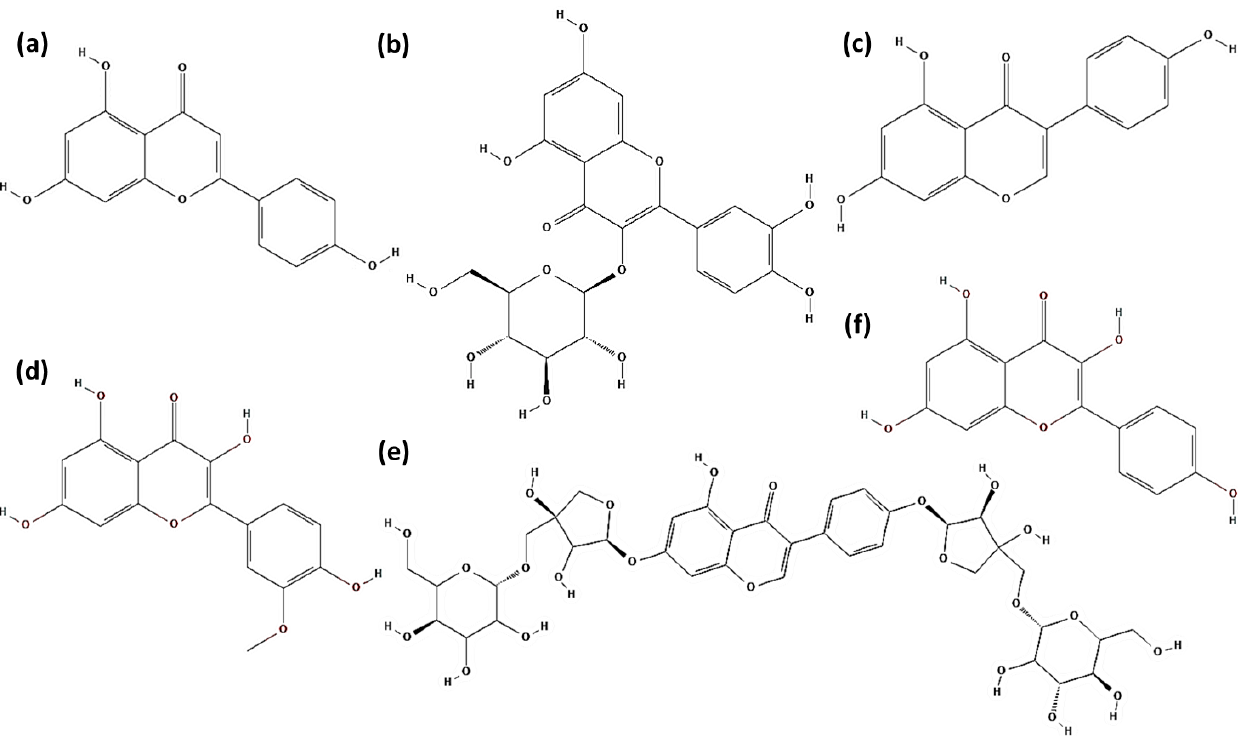
Figure 4. Some examples of flavonoids identified in C. scoparius : ( a ) apigenin; ( b ) isoquercetin; ( c ) genistein; ( d ) isorhamnetin; ( e ) sarothamnoside; and ( f ) kaempferol.